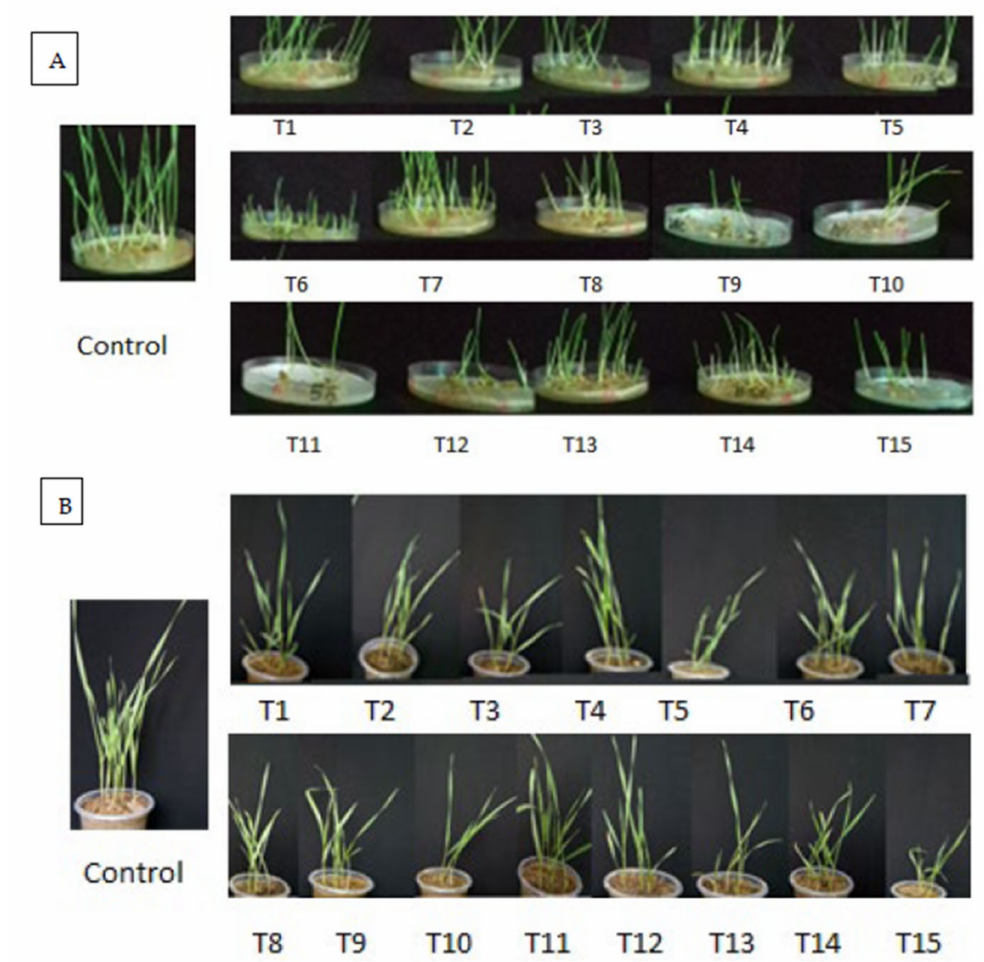
Figure 1. The images express the seedling emergences of wheat ( T. aestivum ) after 10 days in Petri dishes ( A ) and pot ( B ) cultivation that were treated with different root exudates of weeds. T1: Centella asiatica , T2: Rotala indica , T3: Solanum nigrum , T4: ommelina benghalensis , T5: Marsilea quadrifolia , T6: Ageratum conyzoides , T7: Cynodon dactylon, T8: Spilanthes acmella, T9: Heliotropium indicum, T10: Leucas aspera , T11: Phyllanthus niruri , T12: Sida acuta , T13: Mikania micrantha , T14: Polygonum hydropiper , T15: Physalis heterophylla